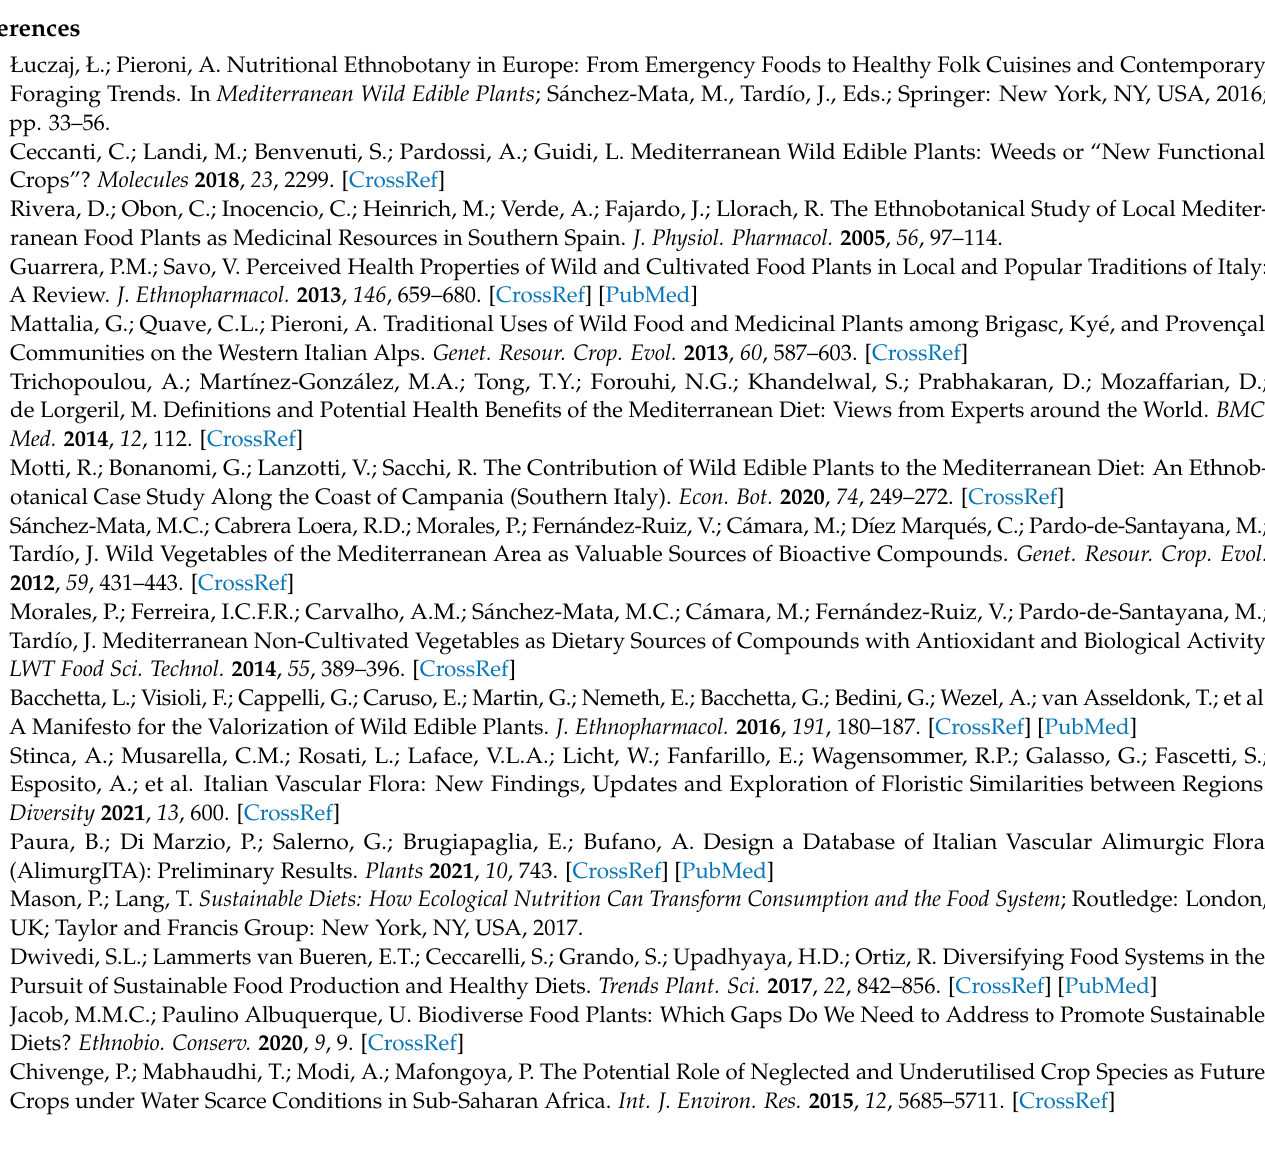
[M − H] − ion for compound 48 . Figure S17: (a) TOF-MS/MS spectrum and (b) proposed fragmenta- tion pathway of the [M − H] − ion for compound 49